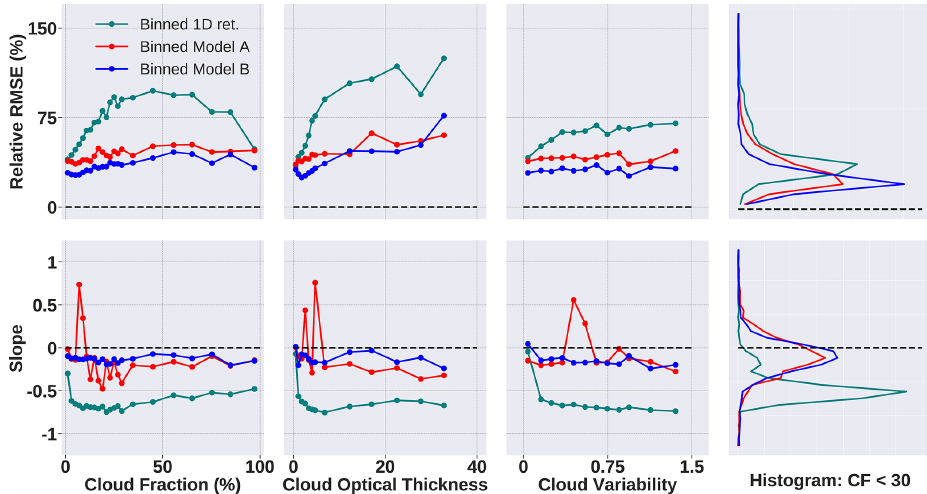
Figure 8. Comparison of two CNN models, A and B (shown in red and blue, respectively), with IPA or 1D retrieval (shown in teal) obtained by methods described in Table 2. Model A is trained on only one scene (coarsened by a factor of 4 × 4), whereas model B is trained on five scenes (also coarsened to a factor of 4 × 4). All three are evaluated on samples from a holdout scene (with shear). The dashed black line depicts the ideal retrieval.